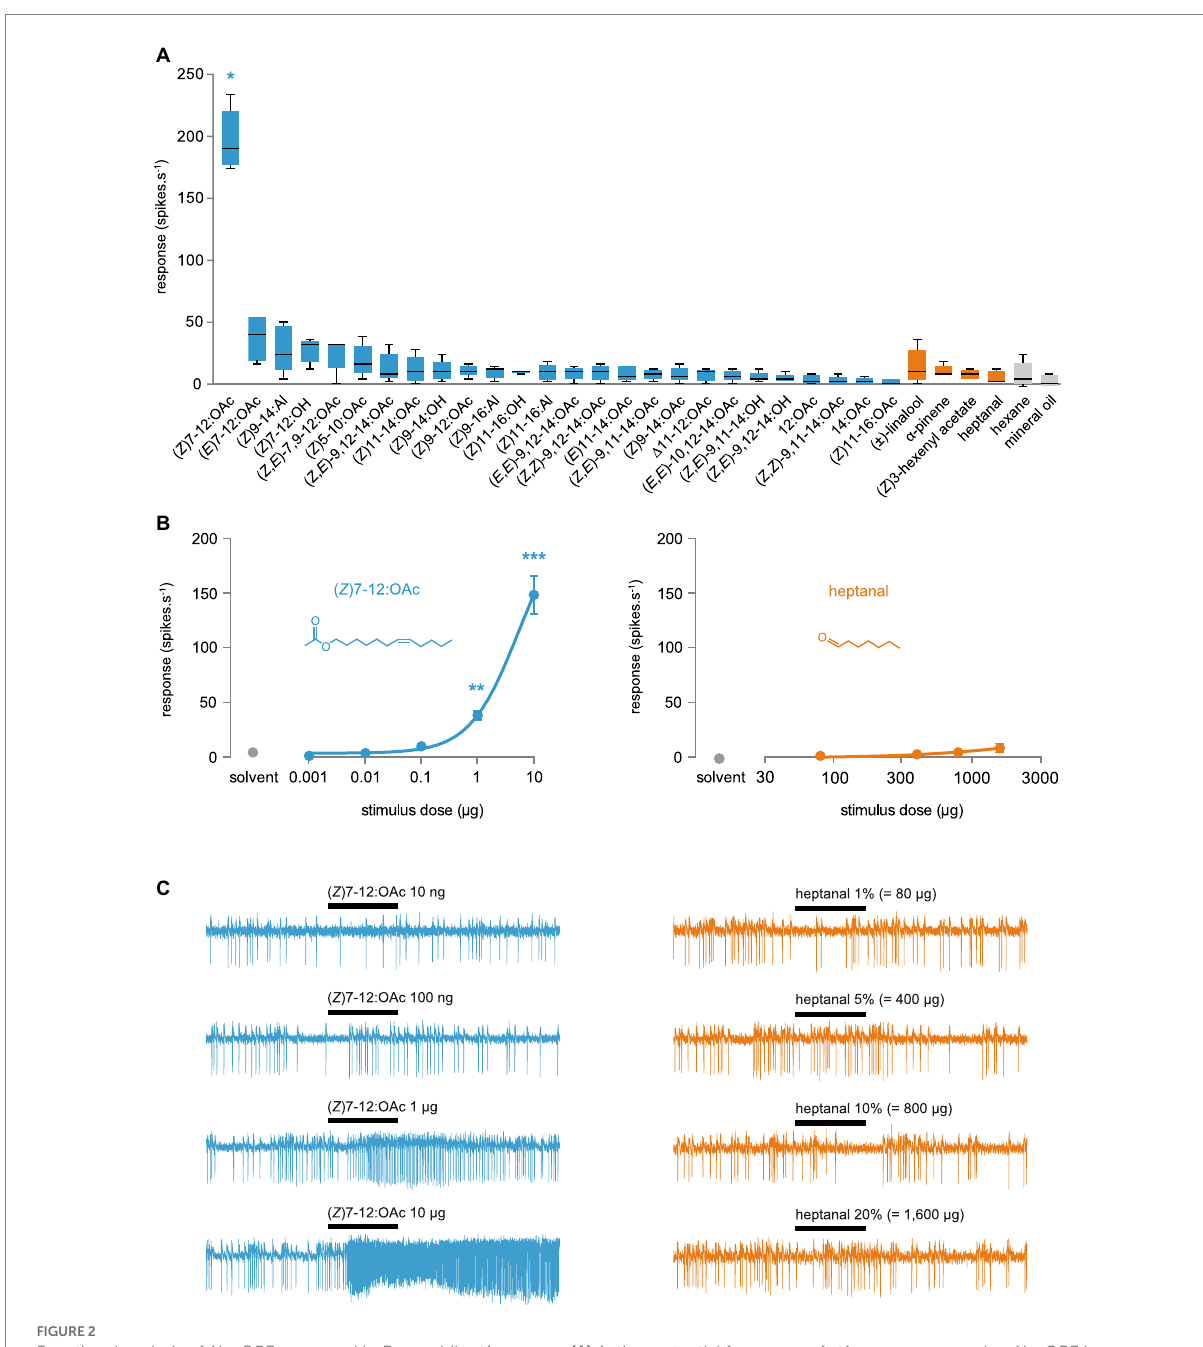
FIGURE 2 Functional analysis of AipsOR3 expressed in Drosophila at1 neurons. (A) Action potential frequency of at1 neurons expressing AipsOR3 in response to 26 moth pheromone compounds (10 μ g in the stimulus cartridge – blue bars) and four volatile plant compounds known to be active on A. ipsilon ( Z )7-12:OAc-responsive neurons (80 μ g in the stimulus cartridge – orange bars). Boxes show the median and the first and third quartiles, and whiskers show the minimum and maximum values of the distribution ( n = 5). * p < 0.05, significantly different from the response to solvent (Friedman ANOVA followed by a Dunn’s post-hoc test). (B) Dose–response curves (mean response ± SEM, n = 11) of at1 neurons expressing AipsOR3 when stimulated with the A. ipsilon pheromone compound ( Z )7-12:OAc or the volatile plant compound heptanal. *** p < 0.001, ** p < 0.01, significantly different from the response to solvent (Friedman ANOVA followed by a Dunn’s post-hoc test). (C) Example of a series of recordings obtained for an at1 neuron expressing AipsOR3. Black bars represent the stimulus (500